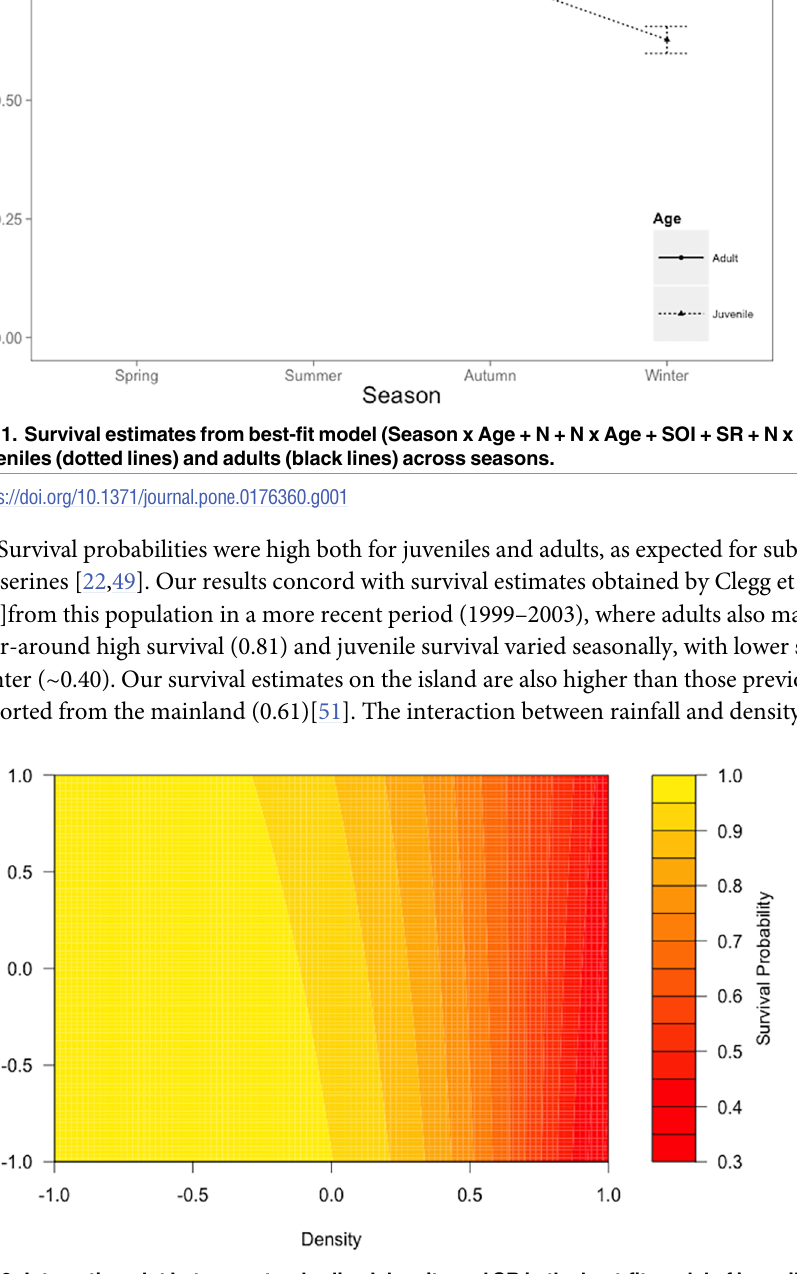
Fig 2. Interaction plot between standardized density and SR in the best-fit model of juvenile and adult survival. The color scale represents survival probabilities, high values in the color scale (yellows) represent high survival probabilities and low values in the color scale (reds) represent low survival probabilities. At lower densitiesand mean rainfall, survival estimates are higher(light yellow), high density results in lower survival estimates (dark red) and survival decreases slightly as rainfallincreasesat mid and high